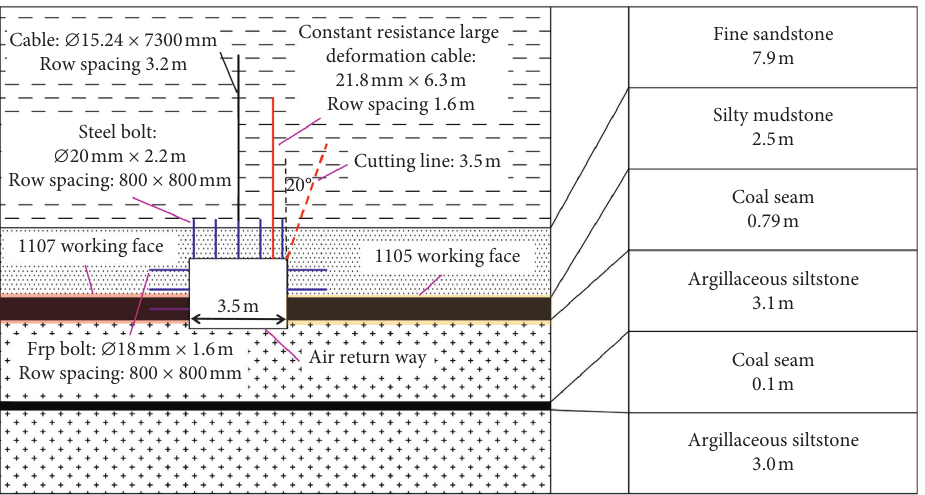
Figure 17: Support